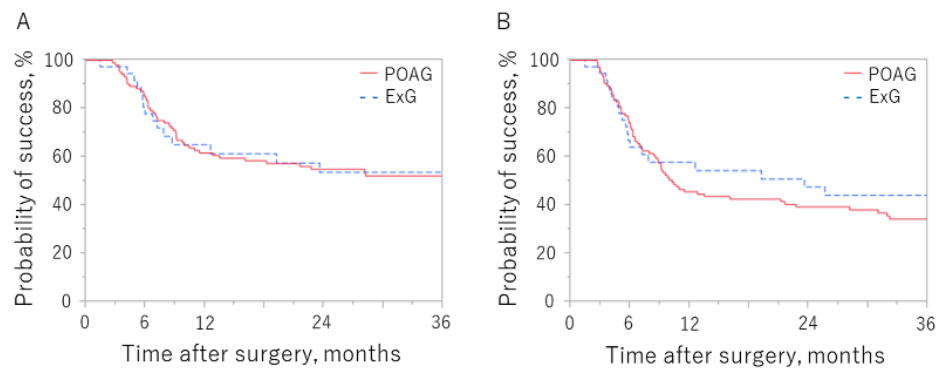
Figure 2. Kaplan–Meier survival curves in the POAG and ExG groups according to which criterion was used to define failure. Criterion ( A ): IOP > 18 mmHg, <20% reduction in preoperative IOP value, or reoperation for glaucoma. Criterion ( B ): IOP > 14 mmHg, <20% reduction in preoperative IOP value, or reoperation for glaucoma. ExG, exfoliation glaucoma; IOP, intraocular pressure; POAG, primary open-angle